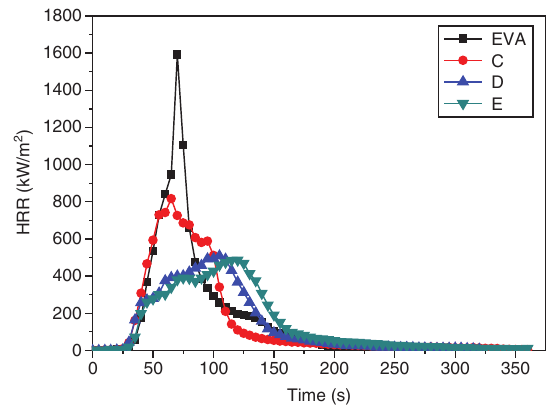
Figure 3: Heat release rate (HRR) for EVA, samples C, D and E.